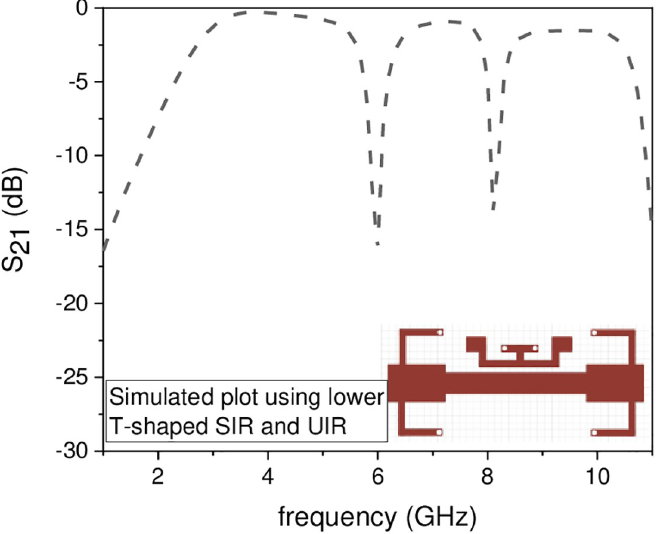
Fig 6. Experimental frequency plot of dual NBs using lower T-shaped SIR and UIR.